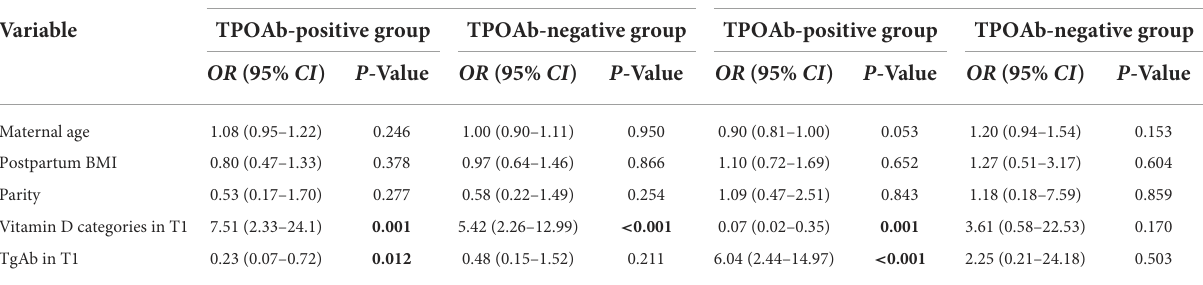
TABLE 4 Multivariate logistic regression analysis in TPOAb-positive and -negative